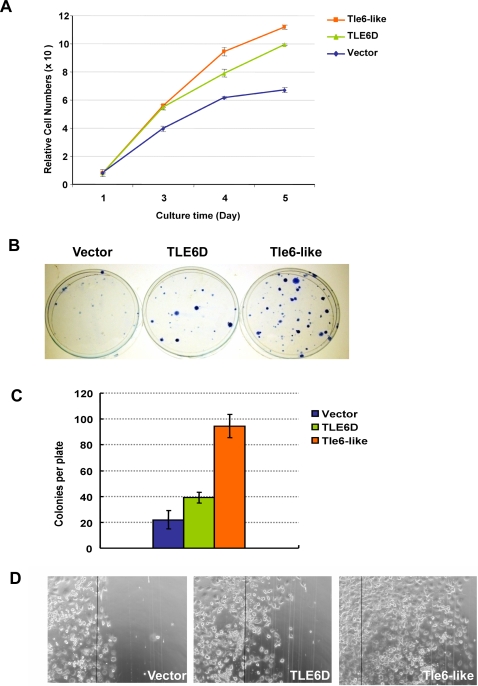
Tle6-like and TLE6D Enhance Cell Proliferation, Colony Formation, and Cell Migration.(A) HCT116 Cell proliferation MTT assay. (B) Representative picture of plates of colony formation assay on MEFs transfected with vector, TLE6D, and Tle6-like. (C) Plot of number of colonies from colony formation assay. (D) In Vitro Cell Mobility Assay. “Wound” was generated by razor blade, clearing the adherent cells on the right side of the slides. Black lines indicate the edge of the “wound”. Representative pictures from HCT116 cells transfected with vector, TLE6D, and Tle6-like are shown.